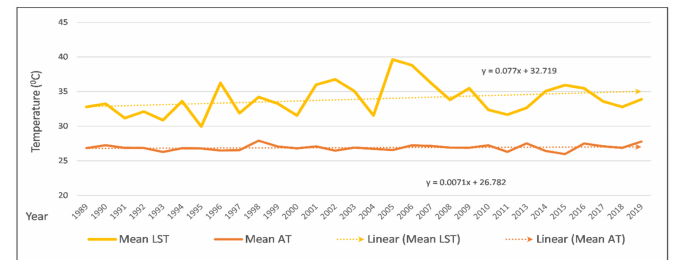
Figure 9. Comparison of Landsat LST with AT in-situ measurements of Phan Thiet weather station from 1989 to 2019.